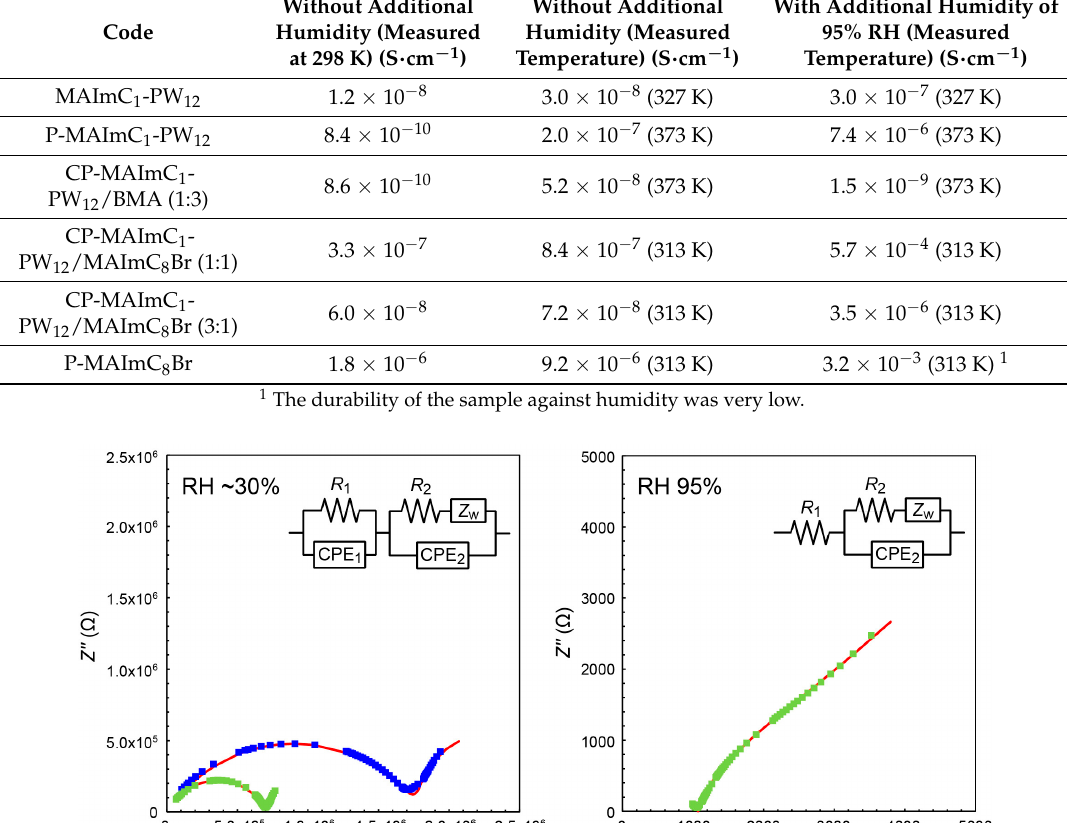
Table 3. Conductivity values of MAImC 1 -PW 12 hybrids with or without additional humidity. Code